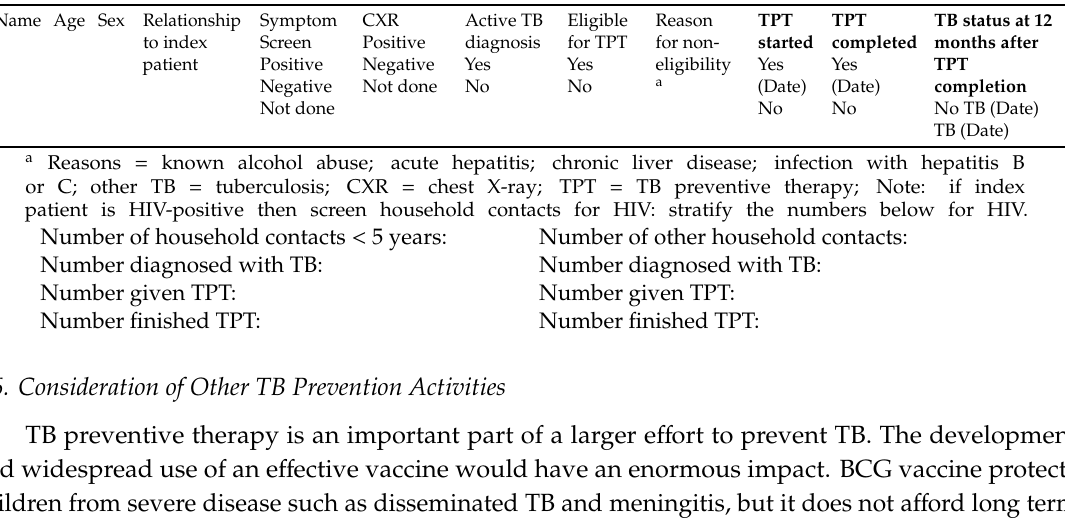
Table 7. TB Preventive therapy master card for household contacts of index patients with TB.